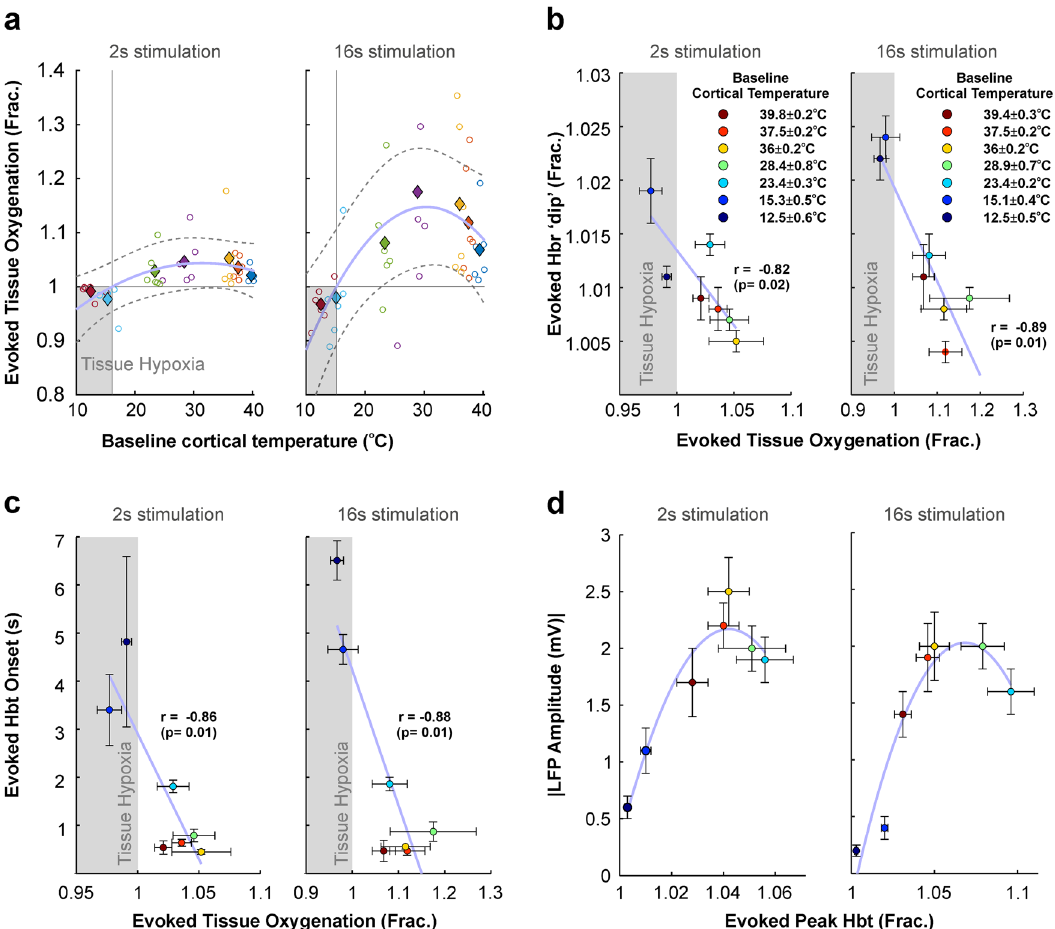
Fig. 5 Evaluation of oximetry, hemodynamic responses, and neurovascular coupling to whisker stimulation under a range of cortical temperatures. a Non-linear relationship between changes in evoked tissue oxygenation as a function of cortical temperature to 2 s and 16 s whisker stimulation. Open circles denote individual animal data, with each colour representing each modulated temperature condition. Filled diamonds of the same colour indicate average across animals. Dashed grey lines denote 95% con fi dence bounds of curve fi tting (light blue) to averaged data. b Negative linear correlation between changes in evoked tissue oxygenation and magnitude of the increase in evoked Hbr concentration ( ’ deoxy-dip ’ ) across cortical temperatures. c Negative linear correlation between changes in evoked tissue oxygenation and onset time of evoked Hbt response. d Non-linear relationship between evoked LFP responses to 2 s and 16 s whisker stimulation, and magnitude of peak evoked Hbt response. a – c Shaded areas indicate cool cortical temperatures during which sensory stimulation induces a transient period of hypoxia. b – d Data points represent averages across animals with xy-error bars as SEM, and colour coded to each modulated temperature condition as given in key in b . See the main text for curve fi tting and statistical